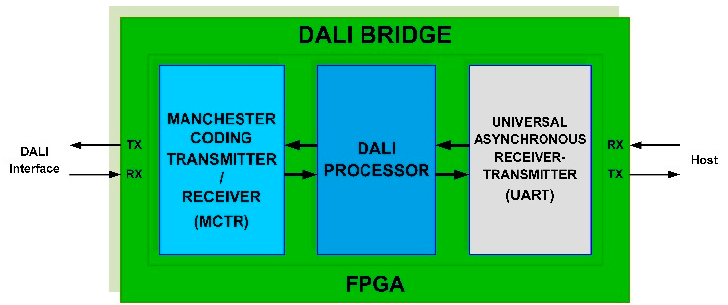
Figure 6. DALI Bridge block diagram.